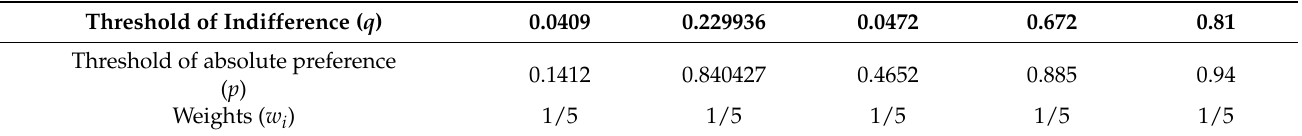
Table 6. The preference thresholds and the weights of the five